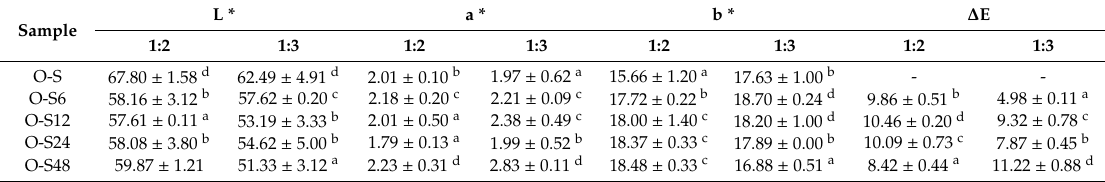
Table 2. Colour parameters of Pickering emulsions stabilized by Maillard induced ODF-SPI conjugates. L * a * b * ∆ E Sample 1:2 1:3 1:2 1:3 1:2 1:3 1:2 1:3 O-S 67.80 ± 1.58 d 62.49 ± 4.91 d 2.01 ± 0.10 b 1.97 ± 0.62 a 15.66 ± 1.20 a 17.63 ± 1.00 b - - O-S6 18.37 ± 0.33 c 17.89 ± 0.00 b 59.87 ± 1.21 Lightness (L *), redness / greenness (a *), yellowness / blueness (b *) and total colour di ff erences ( ∆ E) of Pickering emulsions stabilized with ODF-SPI mixture (O-S) and ODF-SPI conjugates obtained after dry heating at 60 ◦ C for 6 h, 12 h, 24 h and 48 h (O-S6, O-S12, O-S24 and O-S48, respectively). Significant di ff erences within the same columns at p < 0.05 level were denoted by the